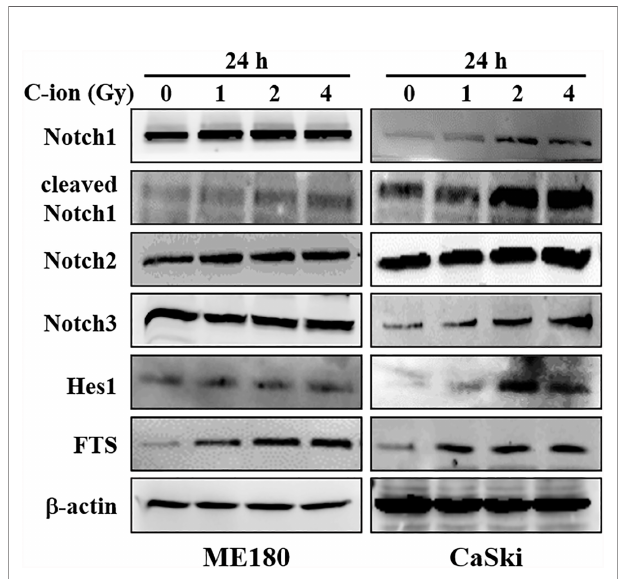
FIGURE 1 | The expression of Notch signaling molecules (Notch1, 2, 3, cleaved Notch1, Hes1) and FTS were increased by C-ion beam in cervical cancer cells (ME180, CaSki). The cells were irradiated with 0, 1, 2 and 4 Gy of C-ion and the protein expression was measured with immunoblot 24 h post-irradiation. The images shown in this fi gure are the representatives of at least three independent